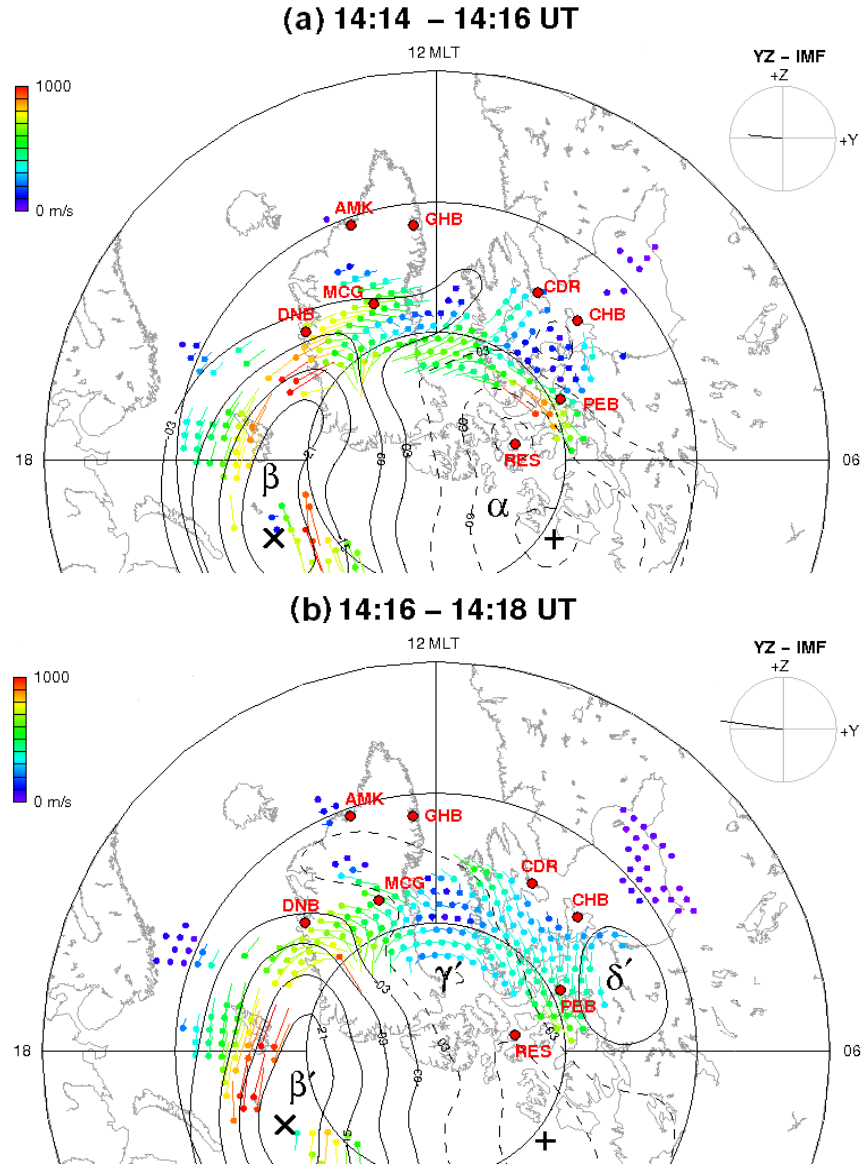
Fig. 6. Northern Hemisphere SuperDARN convection maps for 6 January 1998, between 14:14 and 14:20UT. Each map corresponds to a 2min complete SuperDARN scan. Convection velocities follow the color scale shown on the top left. On the top right of each panel, an inset displays the IMF orientation in the YZ GSM plane, averaged over the scan time. The locations of magnetometers whose data have been described in Sect. 2.2 are also